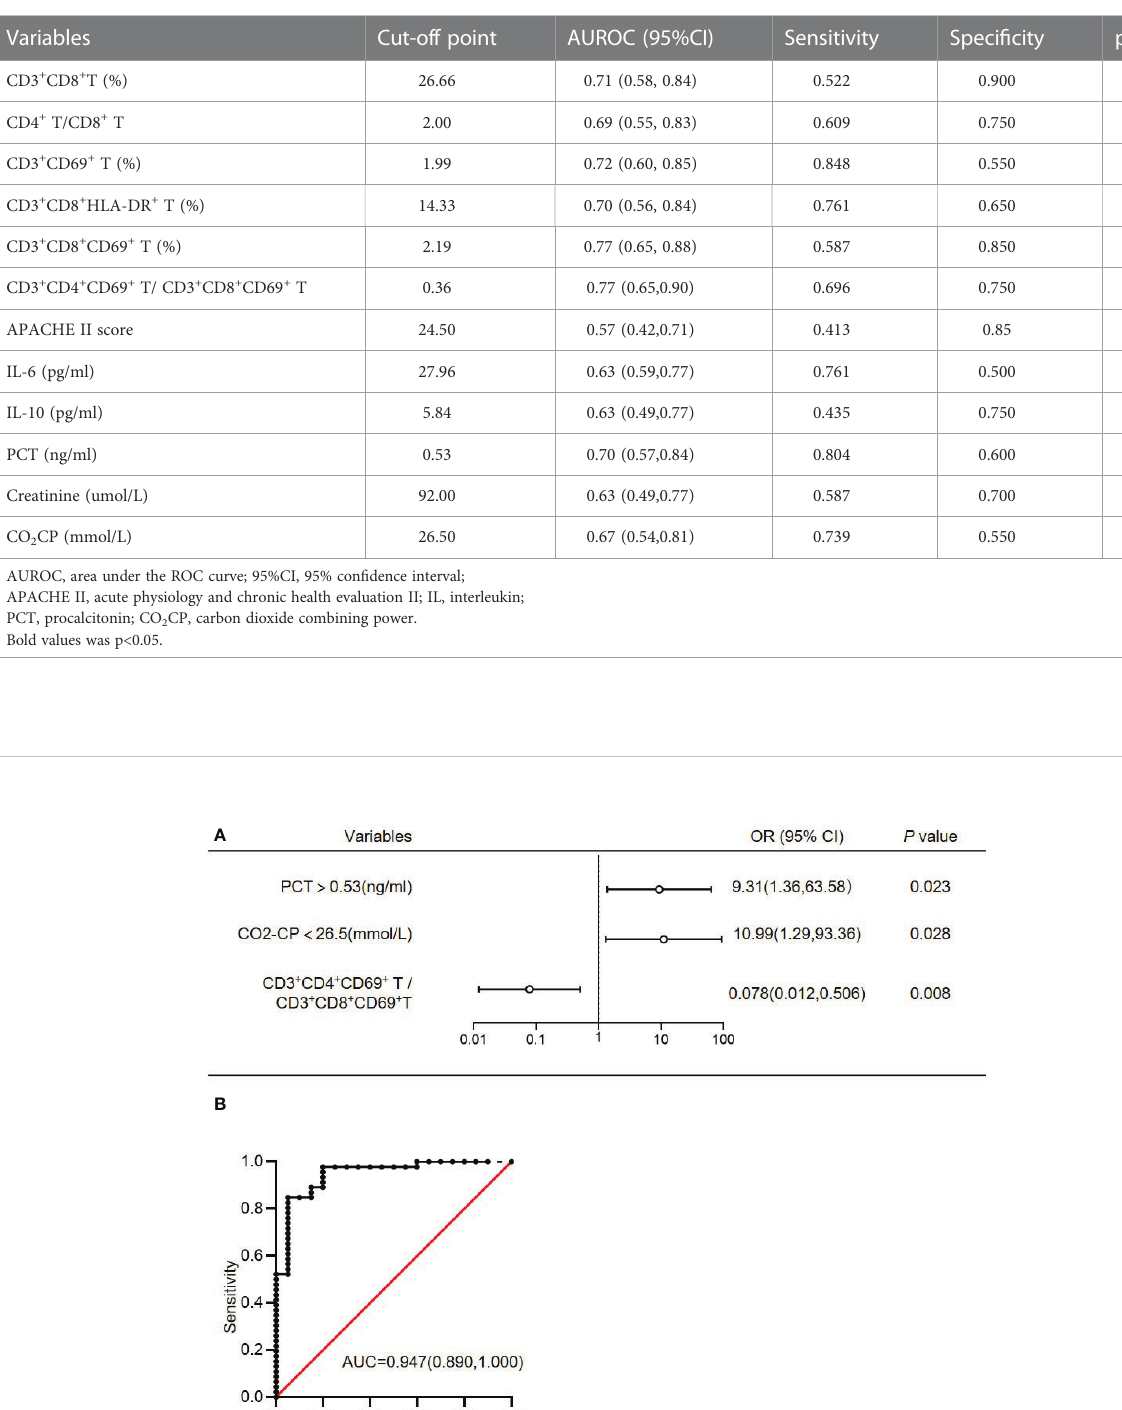
TABLE 5 The AUROC and cut-off points in prediction of G - bacterial sepsis (vs G + bacterial sepsis).